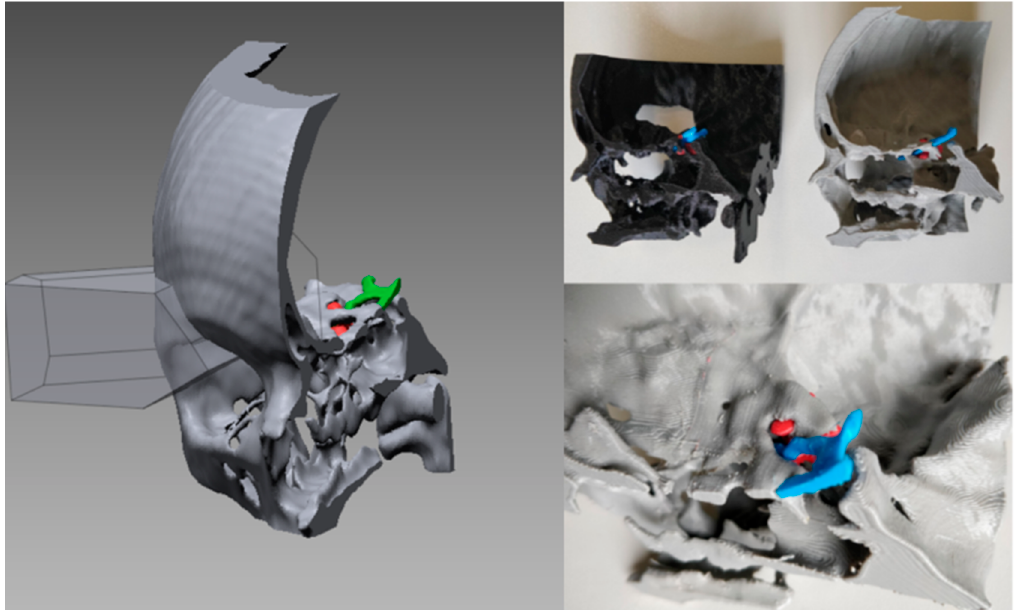
Figure 3. On the left, identification of cutting plans for access to the tumor; on the right biomodels fabricated in Polylactic Acid (PLA). The black model was manufactured directly with the cut identified by the surgeon at the virtual level. The grey model reproduces the entire anatomical portion involved in the surgery.